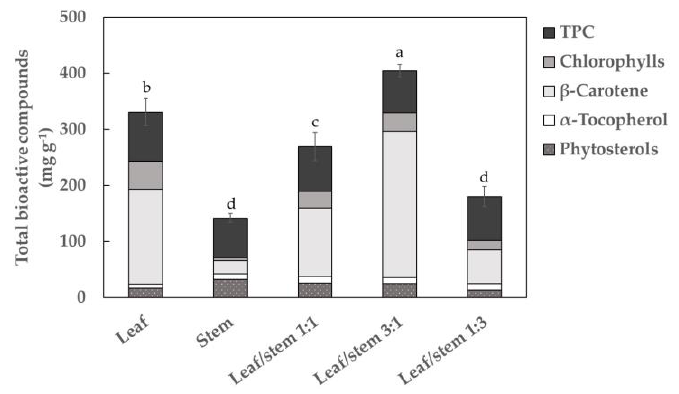
Figure 1. Total bioactive compound contents (mg per gram of extract) in the Parthenon broccoli cultivar by-products (leaves, stems and leaf/stem) in conventional extracts. Values are given as the mean ± SD of three replicates. Different letters (a, b, c and d) denote statistically significant differences according to Tukey´s test ( p < 0.05). TPC: total phenolic compounds.